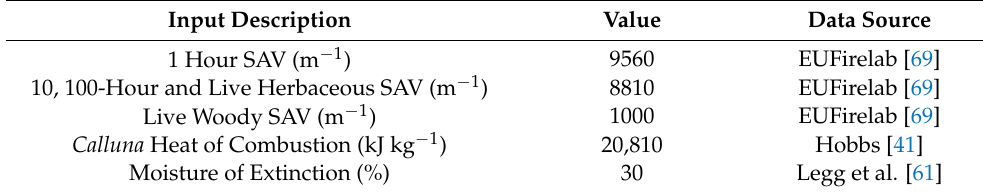
Table 1. Input constants for Roth, BehavePlus, and Farsite. Live herbaceous fuels were combined, based on relative sizes, with 10 and 100 h fuels due to a lack of representation. SAV is surface-area-to- volume ratio. Table adapted from Legg et al.